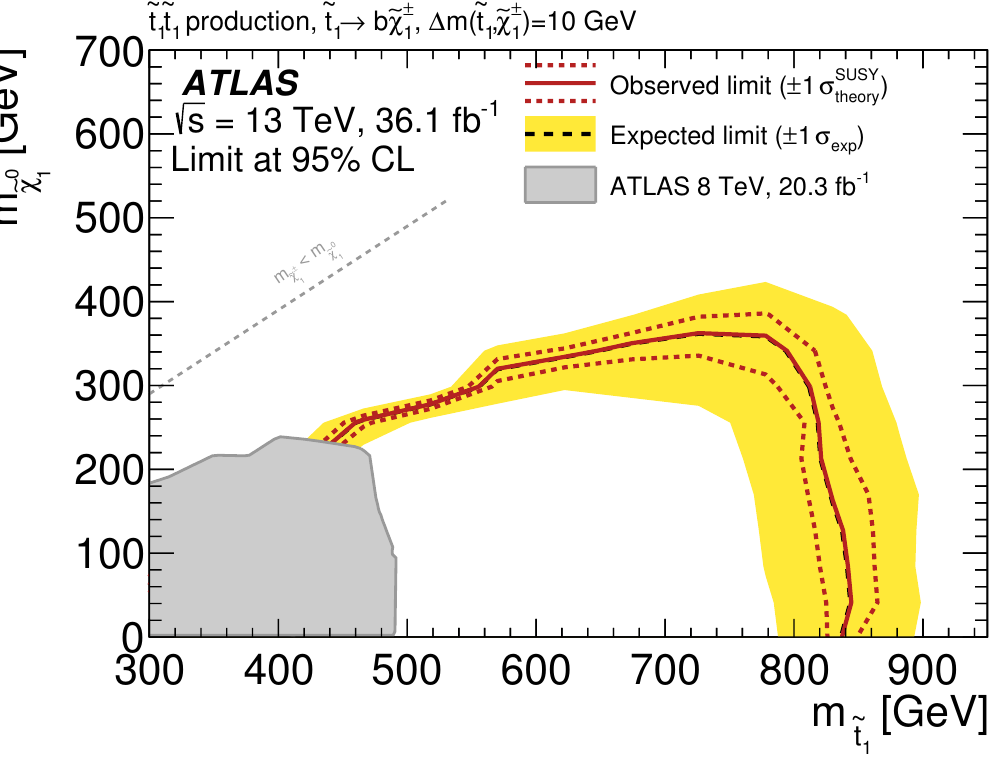
Figure 23 . Expected (black dashed) and observed (red solid) 95% excluded regions in the plane of m versus m ~ for direct stop pair production assuming the b ~ (cid:31) t 1 ~ (cid:31) 0 1 of 100%. The chargino mass is assumed to be close to the stop mass, m